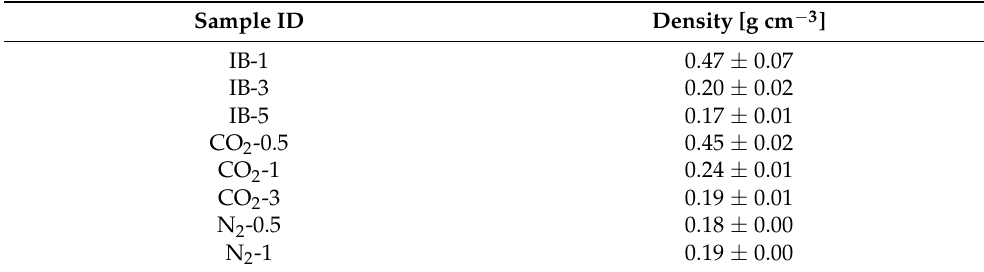
Table 2. Densities of prepared cellulose palmitate